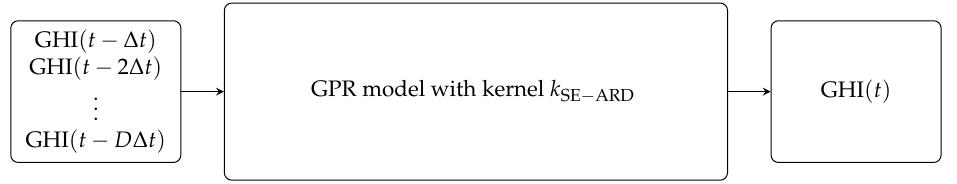
ARD , from which a multi- − ∆ t ) , GHI ( t 2 ∆ t ) , . . . , GHI ( t D ∆ t ) is a vector of − − −